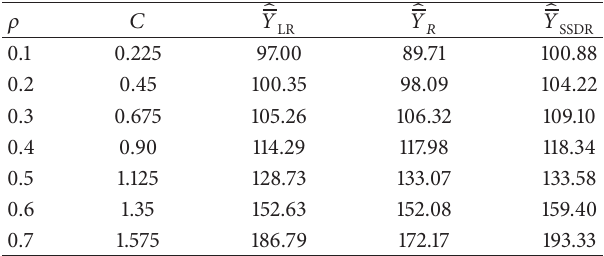
Table 1: Relative efficiencies (in %) of the estimators when 𝑛 = 30 and 𝑅 = 0 .